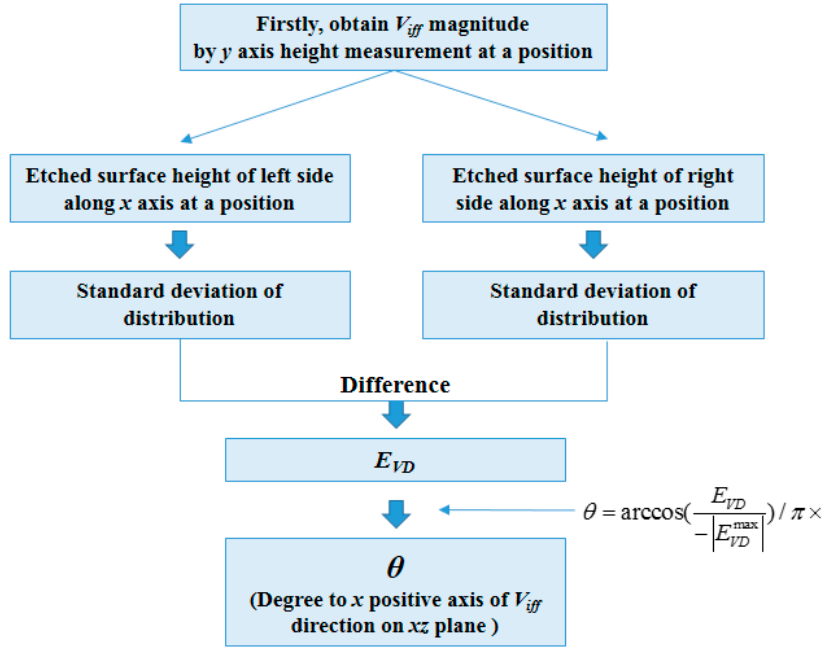
θ V of interdendritic fluid flow velocity iff